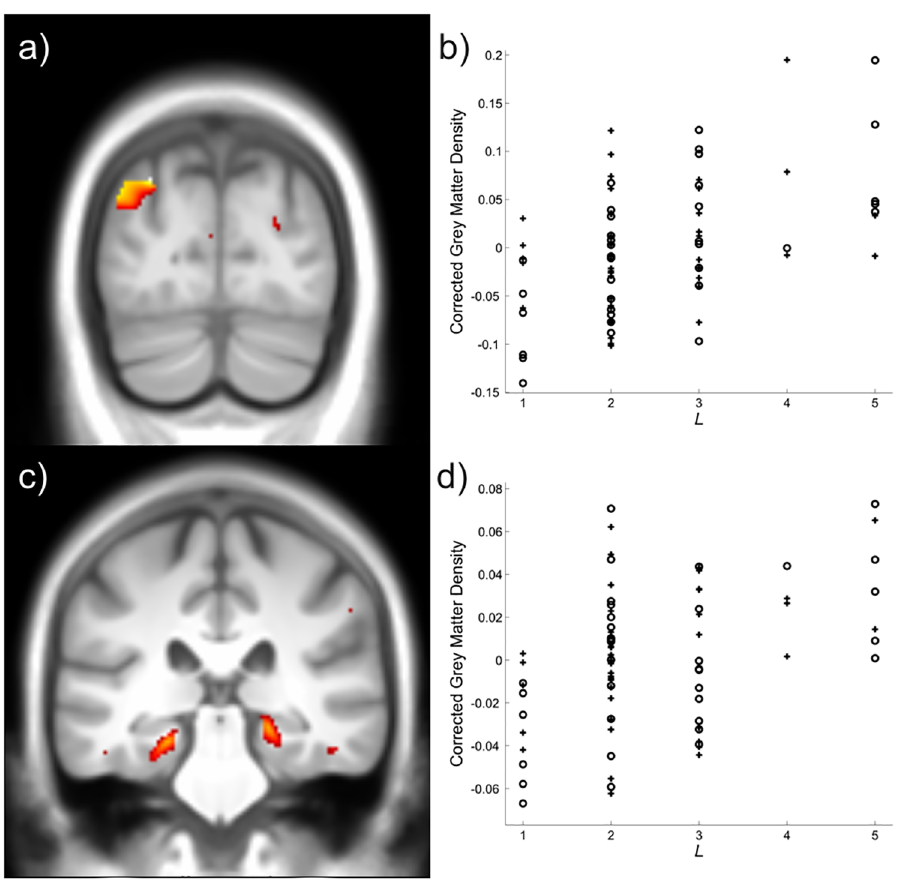
Fig 5. Voxel-based morphometry results for the L regressorencoding the sequence length individual subjects inferred over. 5a,c) L was positivelycorrelatedwith grey matter density in the left posterior parietal cortex (a), and bilateralhippocampus (c). Images thresholded at p < 0.005 uncorrected, cluster size k > 10, for displaypurposes. Slices depictedare at y = -80 (a) and y = -30 (c)5b,d) Scatter plots showingthat both younger(crosses) and older (circles) subjects showeda similar positive relationshipbetween L and grey matter density in both the posterior parietalcortex (b) and bilateralhippocampus (d) Grey matter density extracted from the group level peaks (posteriorparietalcortex: [–29–8039], hippocampus: [–23–30–17] and [21–30–12] collapsedacross hemispheres), and corrected for all other regressors in the designmatrix.